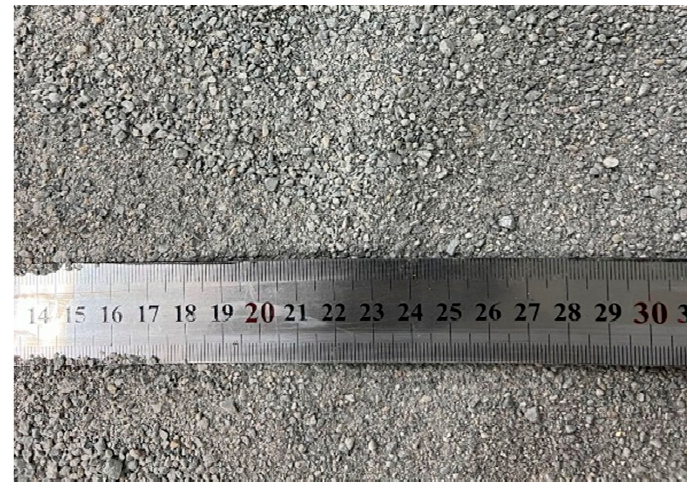
Figure 2. The recycled fine aggregates.